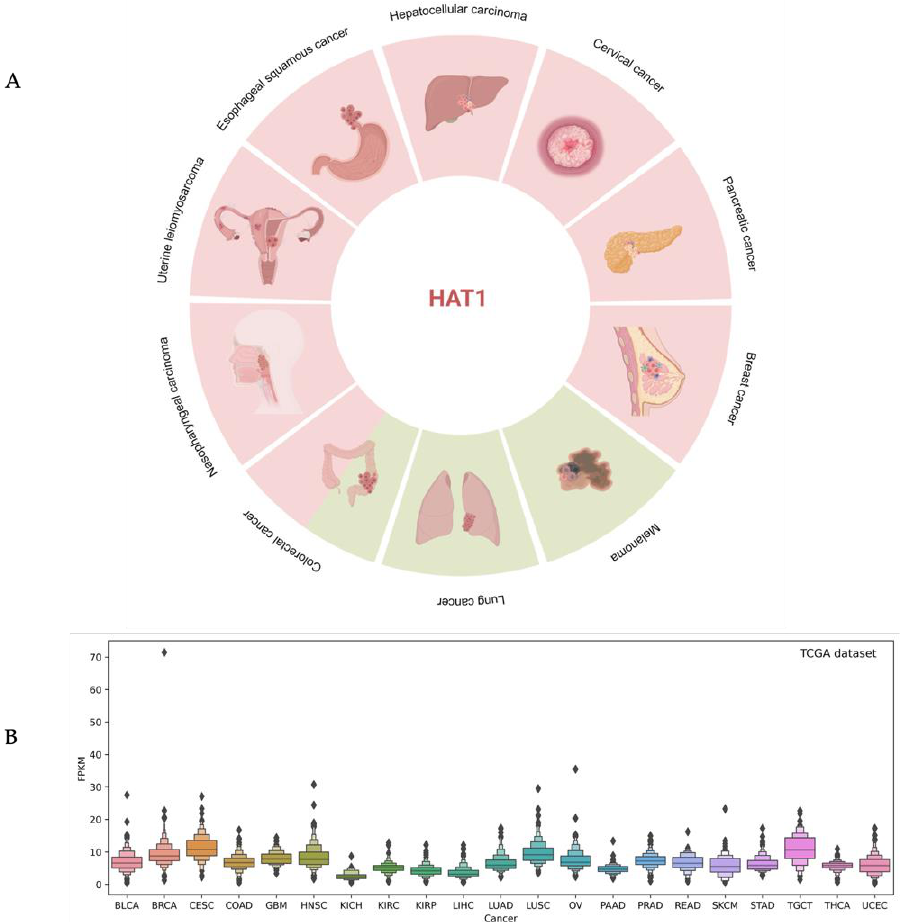
Figure 4. Overview of HAT1 expression in human cancer. ( A ) Schematic representation of the different expression levels of HAT1 in the described cancer. The red and green squares represent the upregulation or downregulation of HAT1 expression levels, respectively. ( B ) The box plot depicts RNA expression levels in 17 different types of cancer from the TCGA dataset; (cid:7) represent outliers that differ significantly from the rest of the dataset.